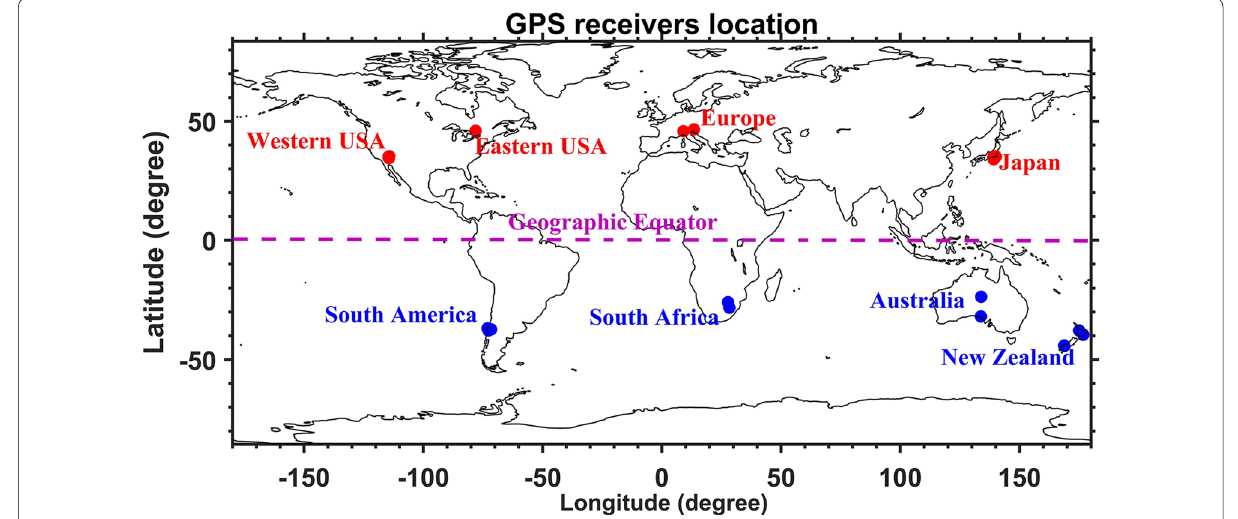
Fig. 1 Location of the GPS receivers used in the present